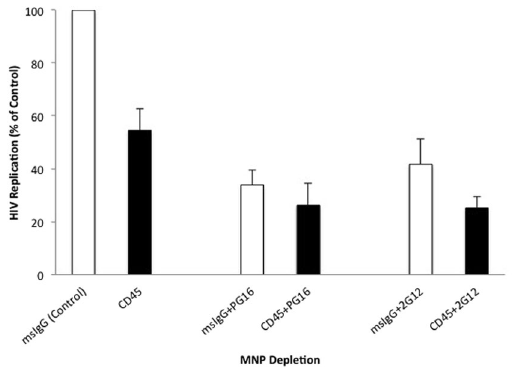
Figure 6. Infection of human tonsillar tissue ex vivo with EV-depleted preparations. Donor-matched human tonsillar tissue blocks were inoculated with HIV SF162 preparations that underwent one or two rounds of depletion using MNPs coupled to antibodies. Left two bars: Viral preparations were depleted with msIgG-MNPs (“mock-depleted”, control, open bar) or anti-CD45 antibody coupled MNPs (black bar). In the two-round depletion experiments the viral preparations were depleted with MNPs coupled to either 2G12 or to PG16 and next depleted with either MNPs coupled to msIgG (“mock-depleted”, open bars) or to anti-CD45 (black bars). Virus released in the medium over 16 days of infection from 27 tissue blocks for each donor was evaluated with p24 measurement and expressed as percent of control. Presented are means ± standard errors of the means (SEM) from experiments with tissues from four